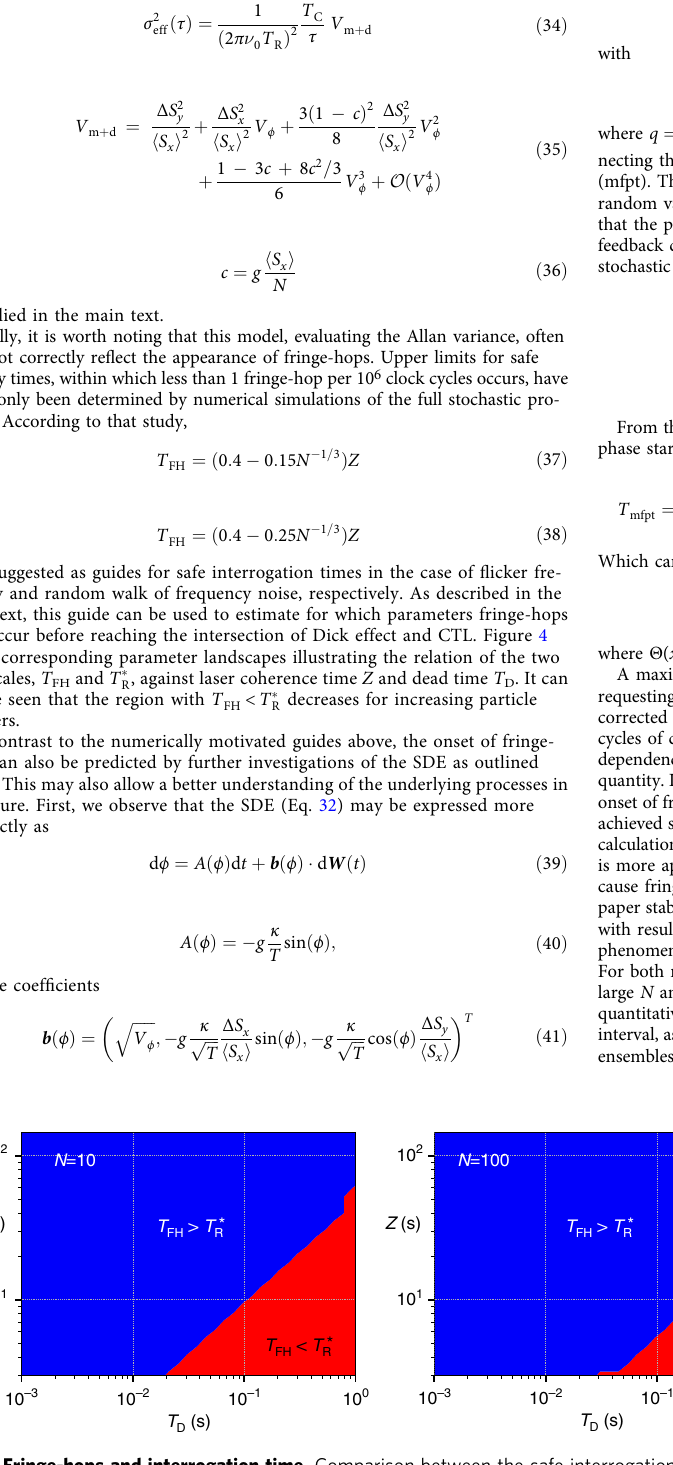
Fig. 4 Fringe-hops and interrogation time. Comparison between the safe interrogation times T FH (without fringe-hops) and the point of intersection for minimal instability as a function of laser coherence time Z and dead time T D . Based on this study we can identify regions in which the minimum between Dick effect and CTL can be safely reached (blue) and regions in which additionally the occurrence of fringe-hops has to be investigated in detail (red). By comparing N = 10, 100, and 1000 one fi nds that the red region is largest for small ensembles, short coherence times and larger dead times and decreases in size with increased particle